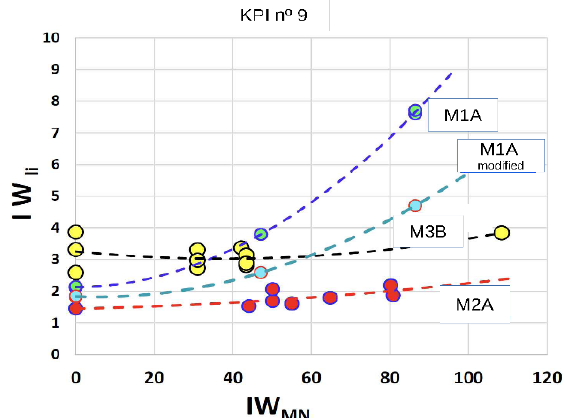
Figure 11. Graph of the values of IW li corresponding to the machines whose data were analyzed.